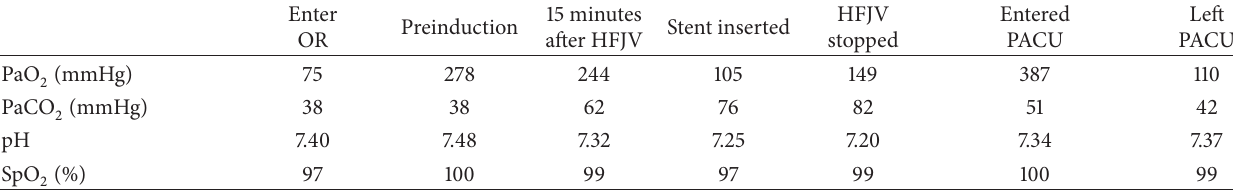
Table 1: Serial arterial blood gas